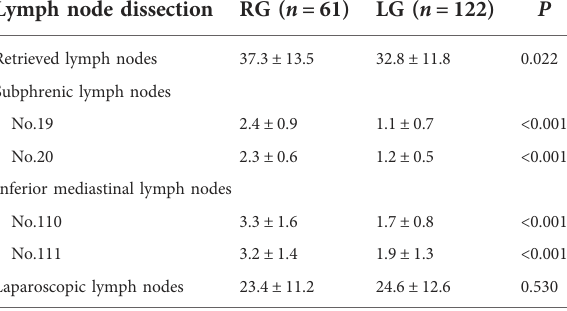
TABLE 4 Comparison of lymph node dissection between robot and laparoscopic